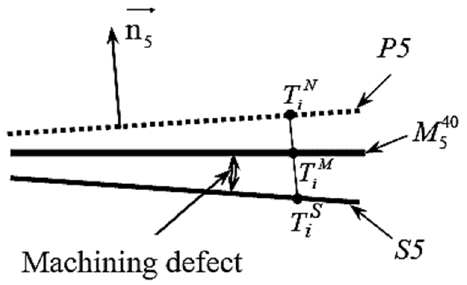
Figure 10. Deviation due to machining.